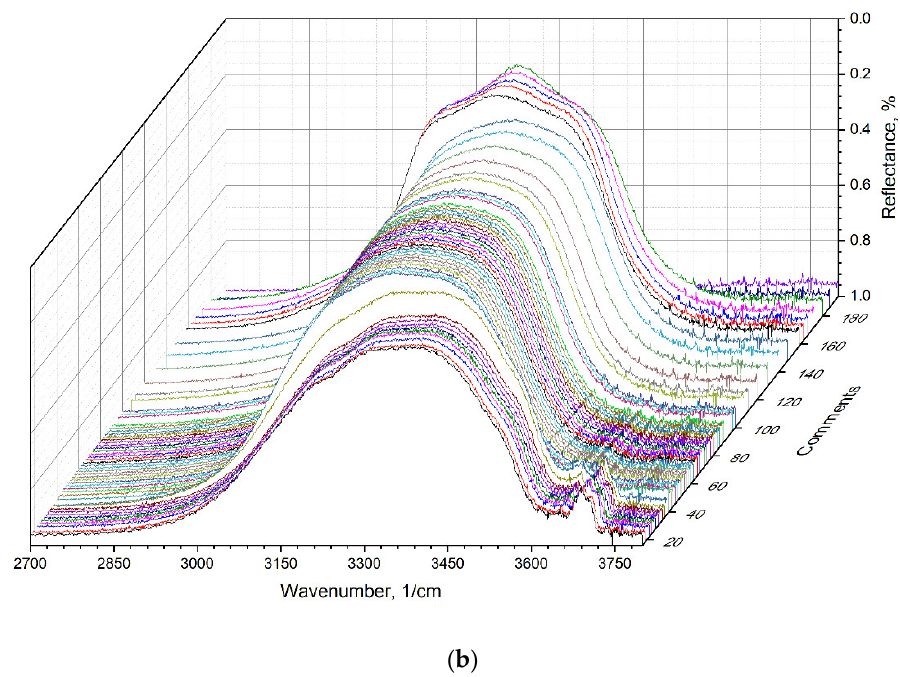
Figure A2. 3D IR spectra of mixture water with argon deposited by PVD method in the temperature range from 20 to 180 K: ( а ) from 2100 to 2400 cm −1 ; ( b ) from 2700 to 3750 cm −1 .